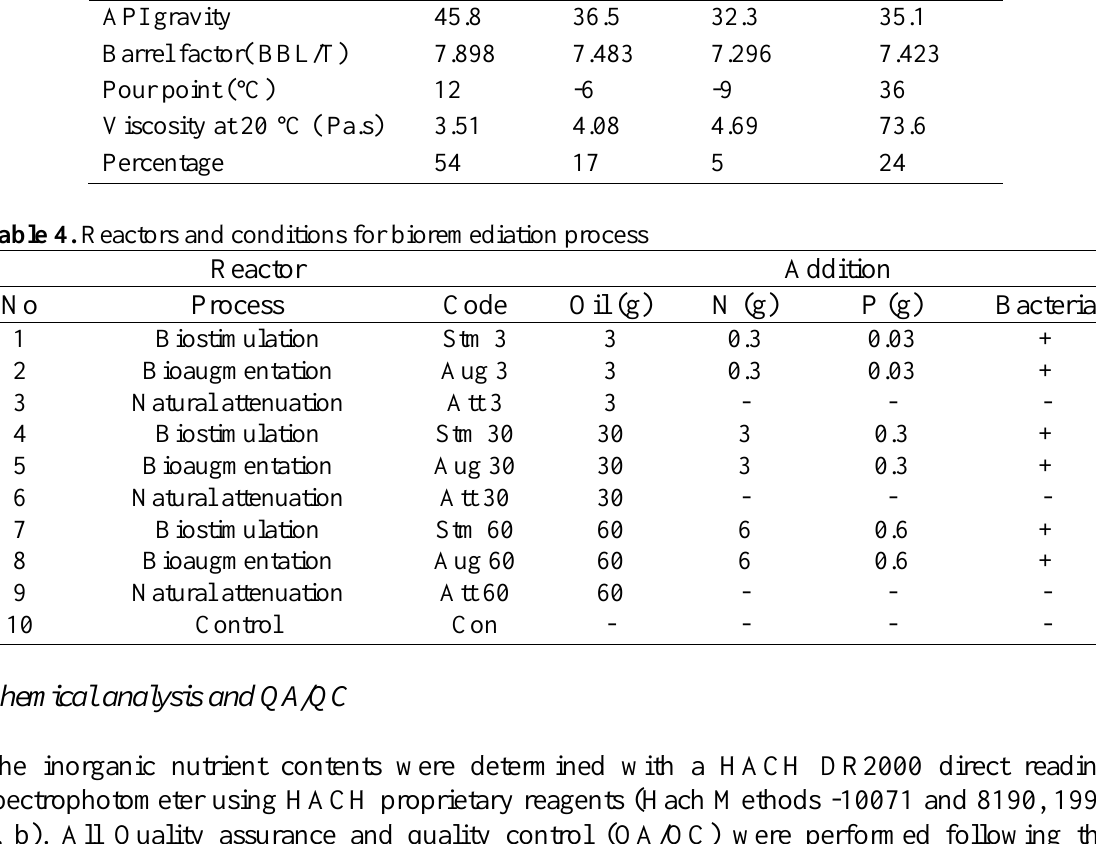
Table 3. Characteristics of the crude oil Characteristic (Unit)